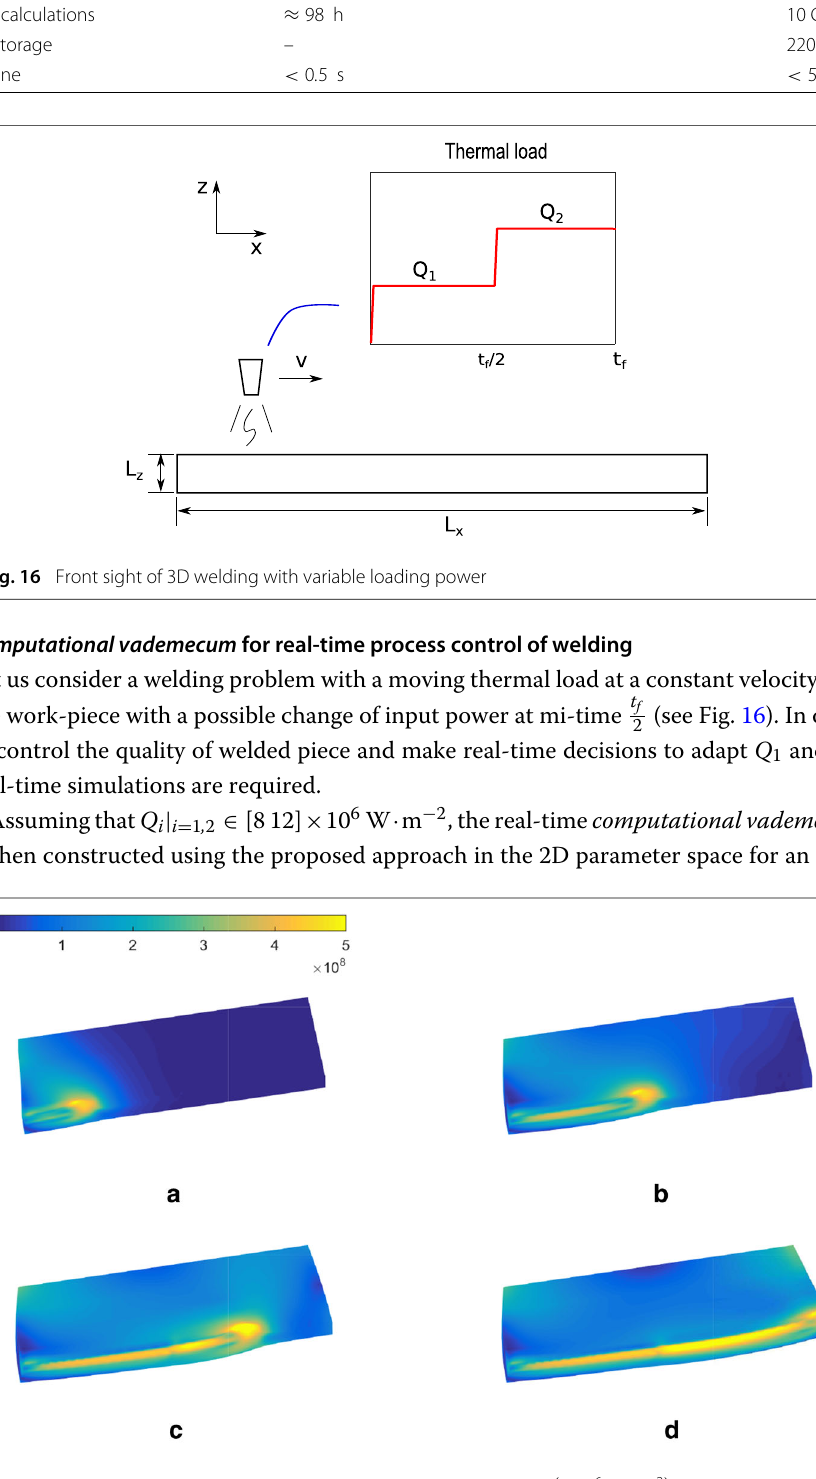
Fig. 17 Evolution of stress during the welding for Q 1 = 8 . 5 ,Q 2 = 11 . 5 t = 122 . 5 s . c t = 210 s . d t = 290